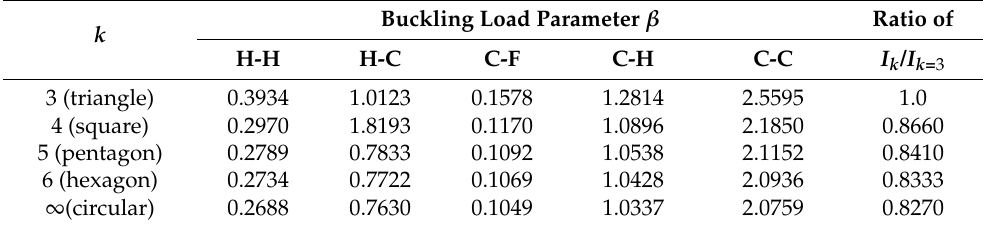
Table 3. Effects of side number k on β with λ = 1 and n =